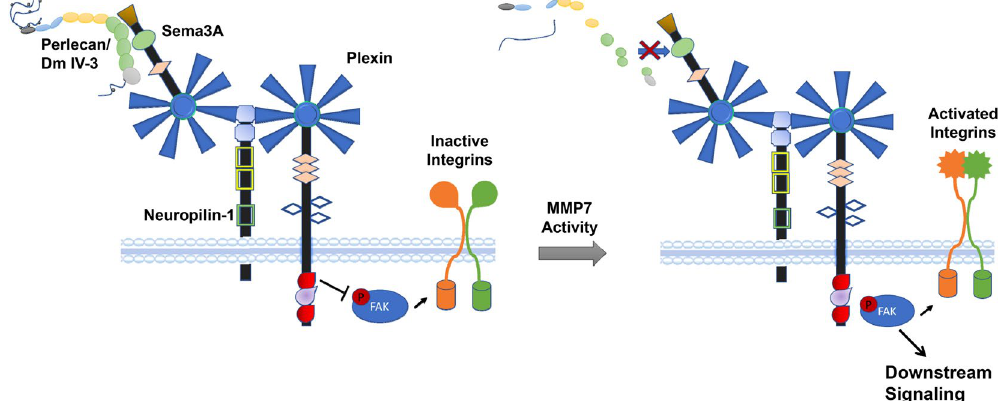
Figure 8. Model of perlecan/Sema3A proposed interactions. In non-invasive prostate overgrowth or early cancer (PCa), intact perlecan is present in the immediate stroma surrounding Sema3A expressing prostatic cells. In this state (left), perlecan engages Sema3A, stabilizing its interaction with the neuropilin-1 and plexin complex. Plexin Ras-GAP activity favors a state of focal adhesion kinase (FAK) dephosphorylation and integrin deactivation. In this state, PCa cell-cell adhesion dominates cell-substratum adhesion, abrogating tissue invasion. As PCa progresses, active MMPs such as MMP-7 can cleave perlecan and/or Sema3A. Ras-GAP activity of plexins is lost, allowing FAK phosphorylation to occur along with subsequent downstream signaling (right). FAK signaling reactivates integrins to favor substrata-mediated dispersion, as seen to occur during tumor dyscohesion and metastasis. GAP = guanosine triphosphate (GTP)ase activation